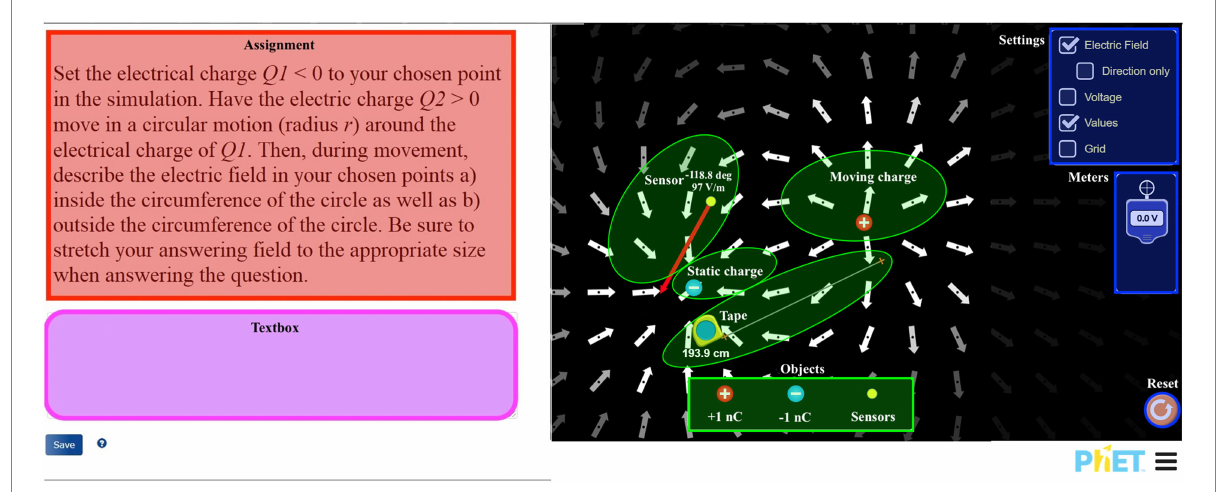
FIGURE 2 The assignment and simulation view the student pairs were looking at when they constructed knowledge on electric field properties in the presence of a negative static charge and positive movable charge. The areas of interest are labeled using colored shapes; the labels were not visible to the students. The students wrote their answers to the problem in the textbox on the left.